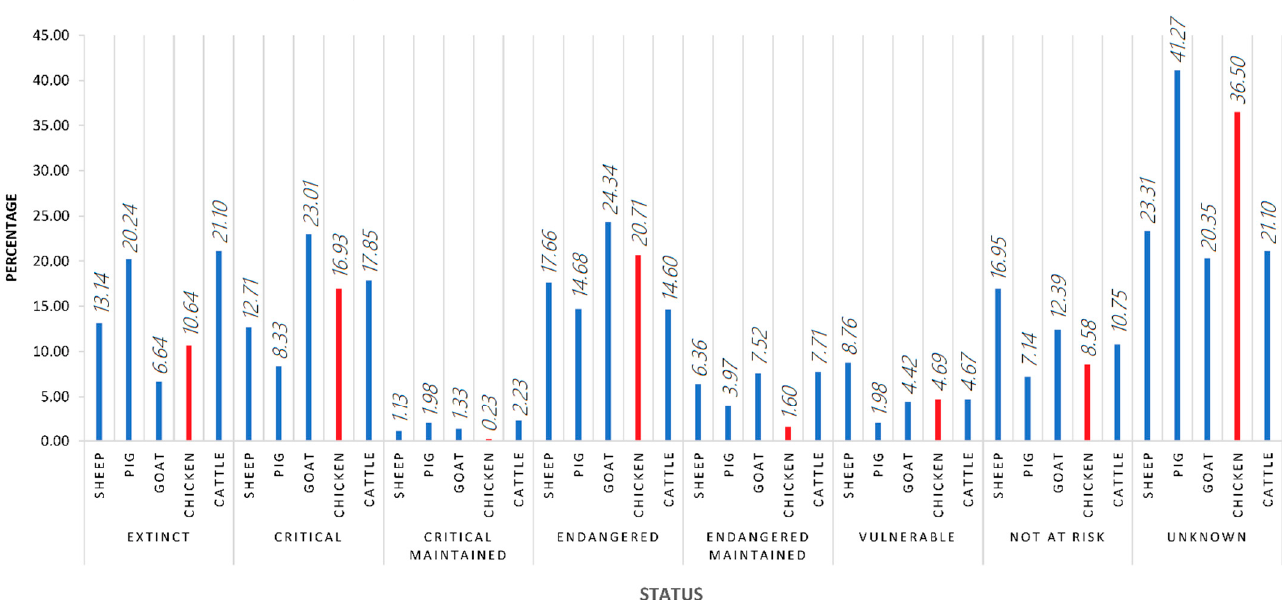
Figure 1. The classification status of European chicken breeds according to FAO DAD-IS halfway through February 2021.